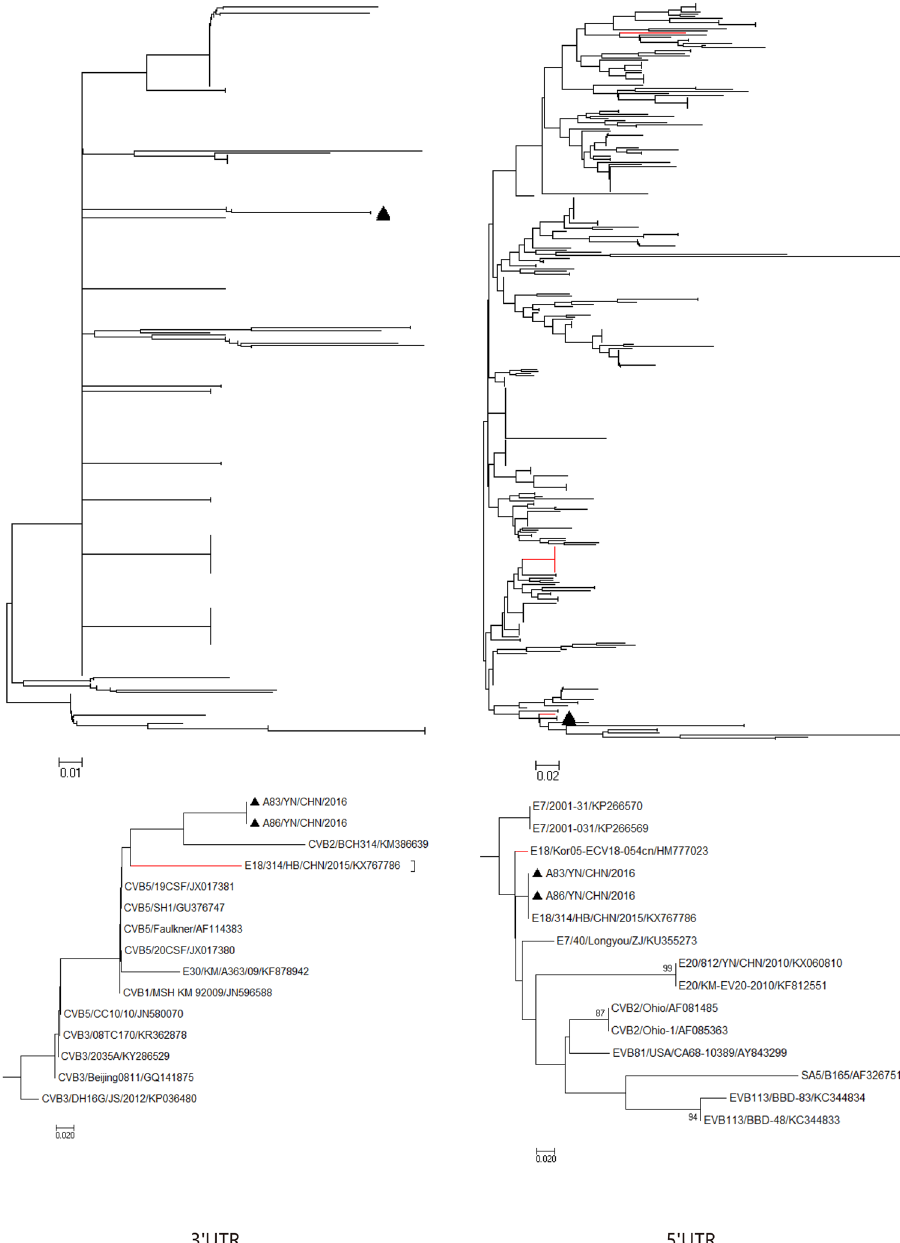
Figure 2. Phylogenetic relationships based on the 5 ′ UTR and 3 ′ UTR sequences of EV-B strains. Two E-18 strains and 343 EV-B strains for 5 ′ UTR, and 349 EV-B strains for 3 ′ UTR available in GenBank database were analysed by nucleotide sequence alignment using the neighbor joining algorithms implemented in the MEGA 6.06 program, respectively. Numbers at the nodes indicate bootstrap support for that node (percentage of 1000 bootstrap replicates). The scale bars represent the genetic distance. Only high bootstrap values ( > 75%) are shown. Only high bootstrap values ( > 75%) are shown. ▲ Strains isolated in this investigation. Red denote the other E-18